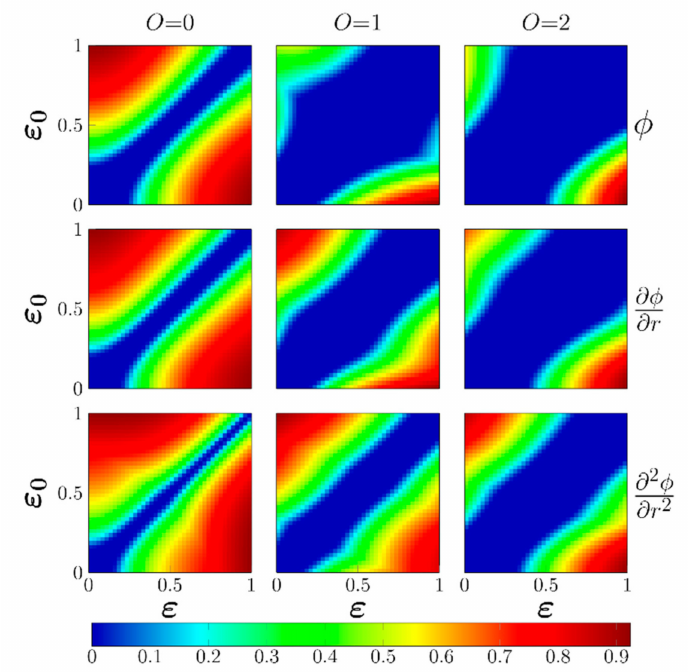
Figure 2. The log10 of the difference between Gaussian radial basis function (RBF) and its Taylor approximation (RBF-TS) as a function of ε and ε 0 for different truncation orders. The rows are for function, first derivative, and second derivative approximations of RBF, while the columns are for zeroth ( O = 0), first ( O = 1), and second ( O = 2) orders of